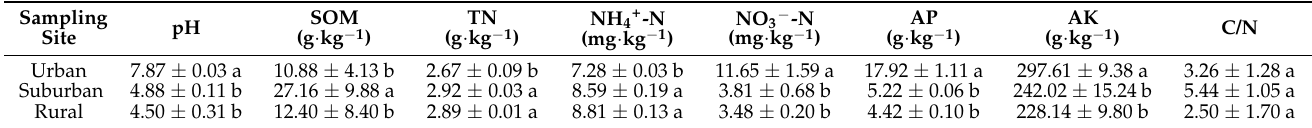
Table 1. Soil physicochemical properties in Quercus acutissima forests along the urban–rural gradient. Sampling